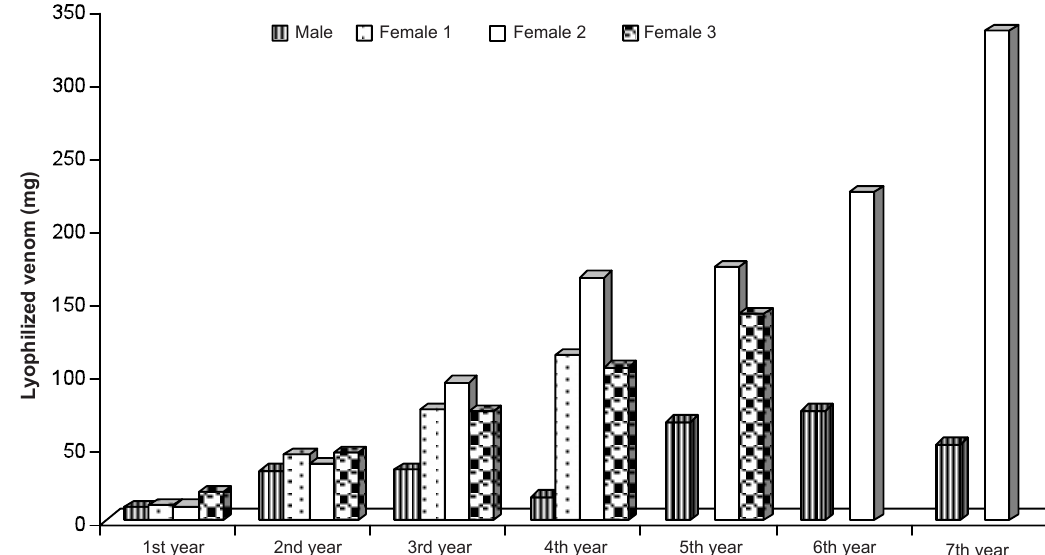
Figure 3. Bothrops insularis : venom produced (mg) (lyophilized venom) during 7 years (median per